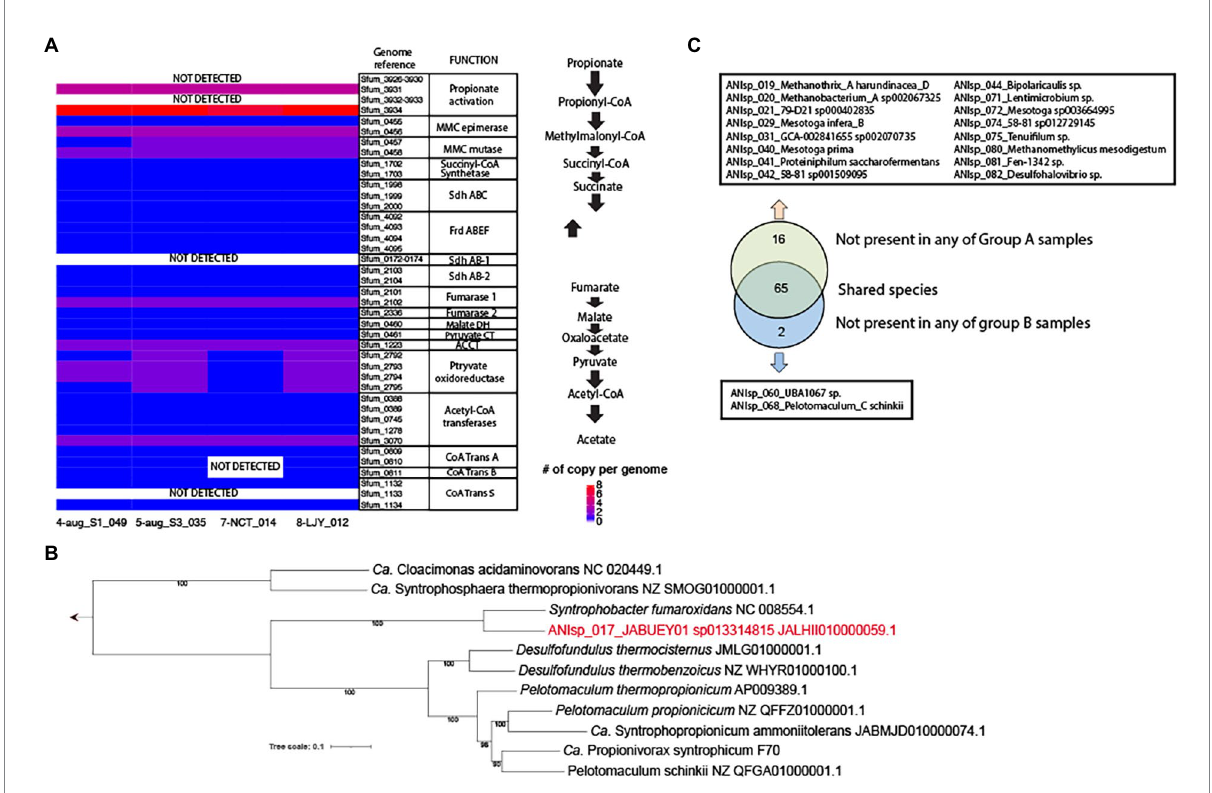
FIGURE 3 Presence and absence of MAGs in group A vs. group B metagenomes and potential for propionate degradation in key species. (A) A copy number of genes per genome for the methylmalonyl-CoA pathway in 4 MAGs of ANIsp_017_JABUEY01 sp013314815. MMC, methylmalonyl-CoA; Sdh, succinate dehydrogenase; Frd, fumarate reductase; DH, dehydrogenase; CT, carboxyltransferase; ACCT, acetyl-CoA carboxyltransferase; CoA Trans, coenzyme A transferase. (B) Phylogenetic genome tree of ANIsp_017_JABUEY01, which is highlighted in red, and known propionate degraders. The genome sequence of Ca. Propionivorax syntrophicum F70 was kindly provided by Dr. Morten Simonsen Dueholm. (C) A diagram representing presence and absence of MAGs in group A vs. group B